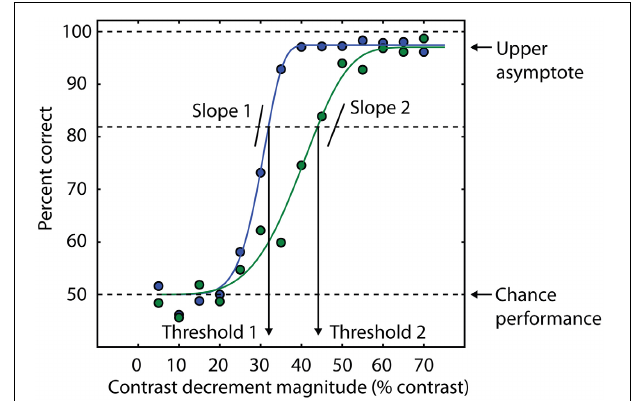
FIGURE 2 | Psychometric curves contain multiple sources of information about behavioral performance. Behavioral performance, measured here as percent correct trials, is plotted as a function of a stimulus parameter (blue and green data points). In this example, the independent variable is the amount of decrement in contrast required to detect the presence of a target (see text and Yoon et al., 2009, 2010). Smaller contrast decrements are more difficult to discriminate, so the psychometric curve is monotonically increasing. In this example, cumulative Weibull functions are fit to the data (smooth green and blue lines). For each function, threshold is defined as the amount of contrast decrement that yields 82% correct trials. The percent correct corresponding to chance performance determines the lower asymptote of the curve (50% in this example). The blue curve has a lower threshold than the green curve, consistent with a higher percentage of correct trials at an equivalent contrast decrement compared to the green curve. Different slopes in the two curves indicate different levels of reliability across experimental conditions or groups of subjects. The upper asymptote is an index of attentional lapses, as the stimuli for these trials are well above perceptual threshold, and performance less than 100% indicates that attention was not properly engaged on some trials. The difference between the upper asymptote of the curve and 100% correct performance is a measure of the rate at which subjects are responding incorrectly on trials that should be easy to perform at 100% accuracy based on the physical level of the stimulus (e.g., large values of the contrast decrement in this task). This difference is comparable to estimates of the lapse rate in catch trials (e.g., Barch et al.,